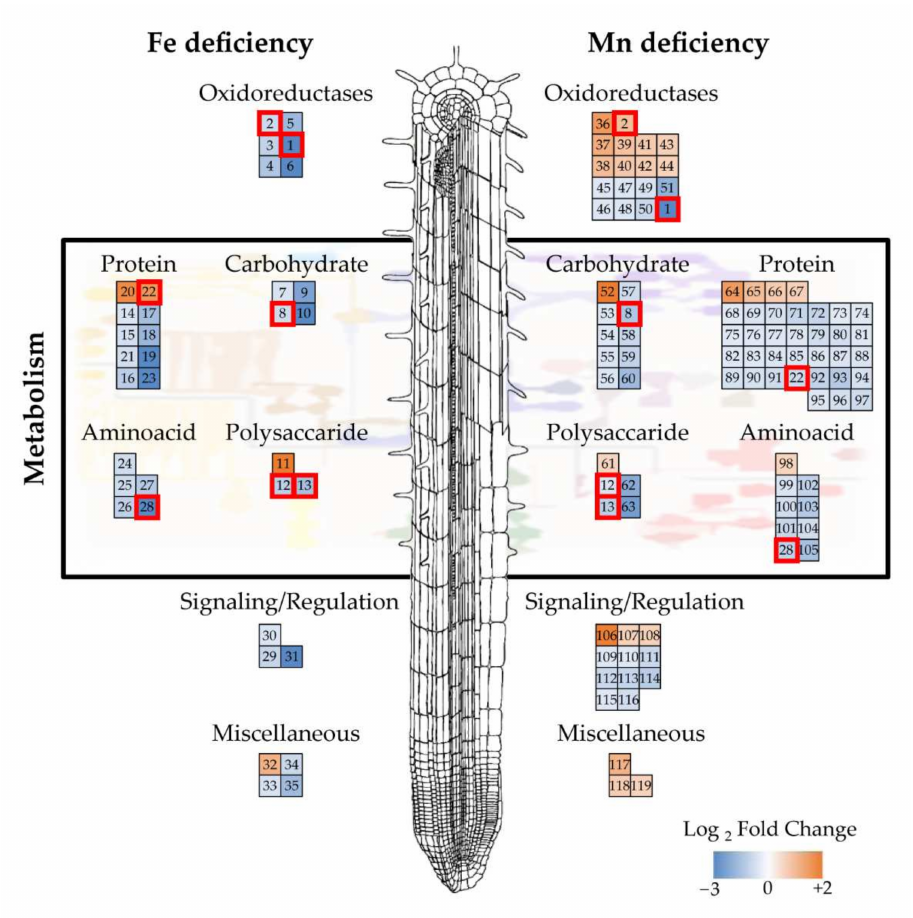
Figure 3. Functional classification and heatmap of proteins accumulated differentially in the root protein profile under Fe deficiency (left panel) and Mn deficiency (right panel). Numbers correspond to those presented in Tables 2 and 3. Proteins identified to respond to both deficiencies are marked in red